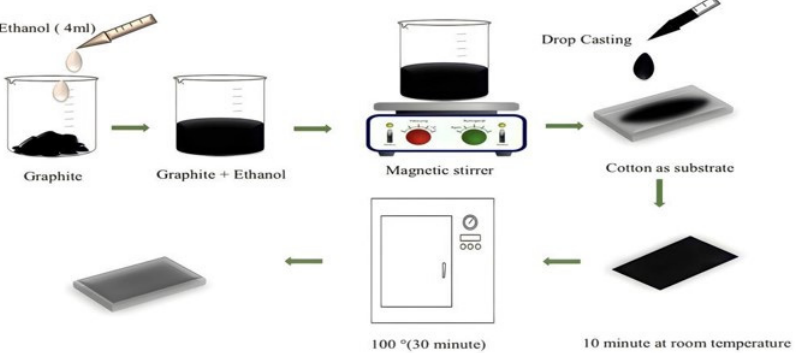
Figure 1. Schematic diagram of the preparation of a graphite-based conductive cotton fabric, including the preparation of the graphite solution.